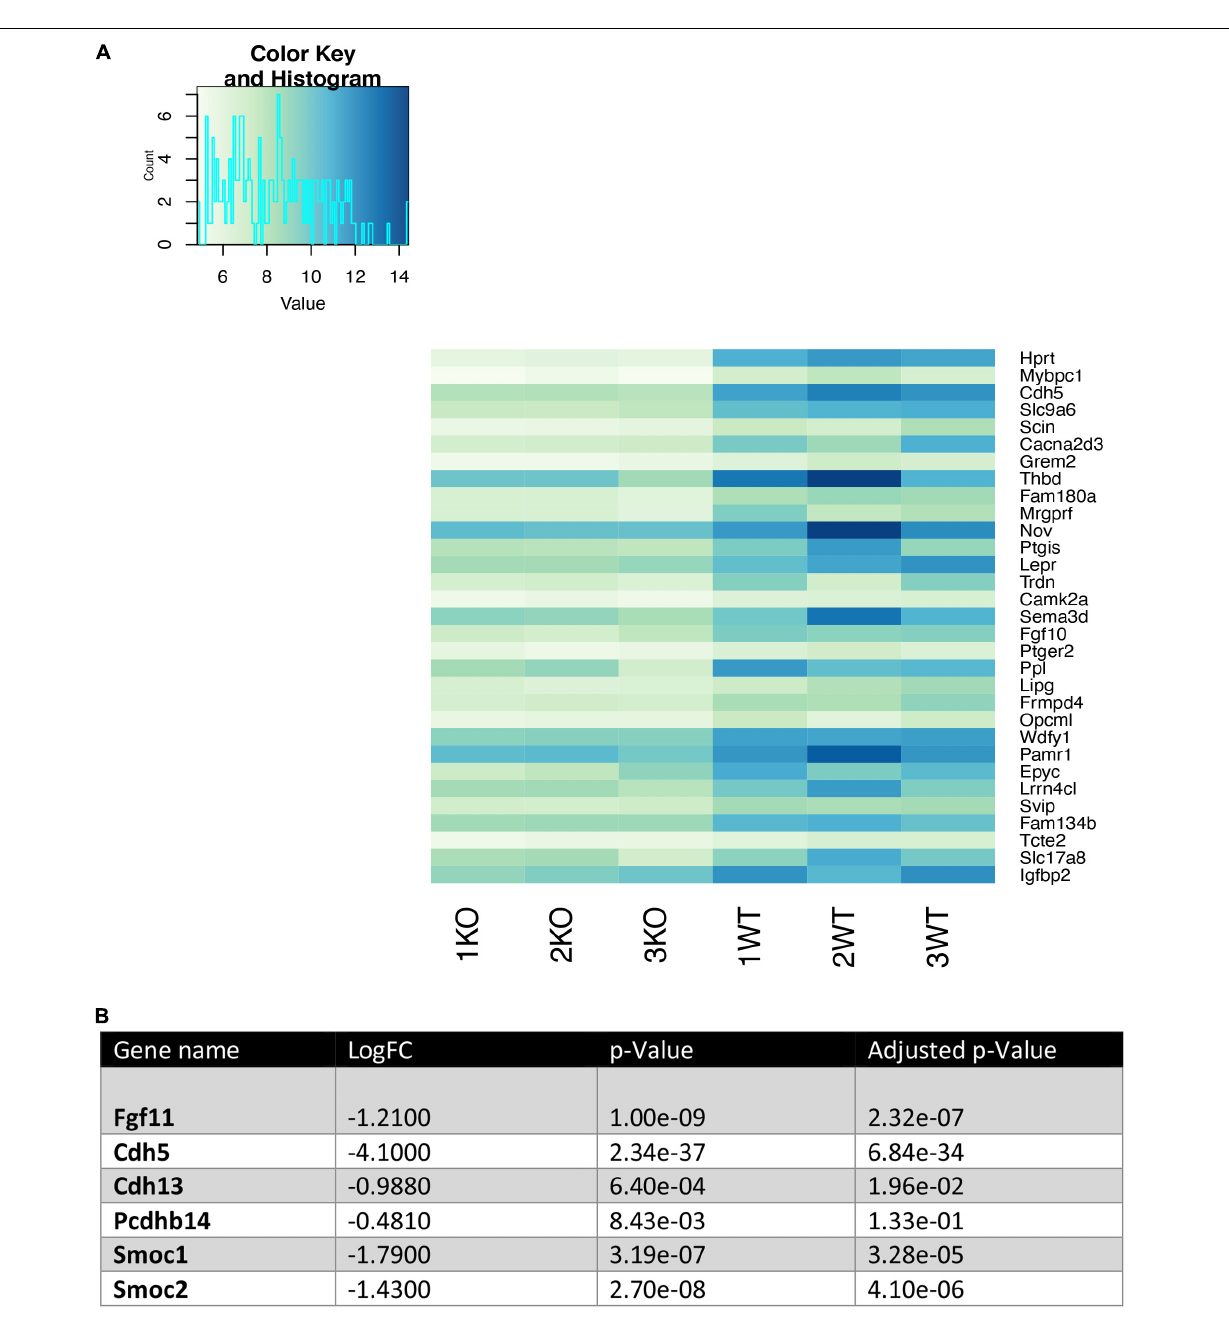
FIGURE 3 | Heatmap of the 30 most downregulated genes in Nhe6 -knockout compared to wildtype endothelial cells. Heatmap shows RNA sequencing results of the 30 most downregulated genes in Nhe6 -knockout (KO) compared to wildtype (WT) cells. (A) Some of the most prominent differences are evident for Hprt , Cdh5 , Thbd , Nov , Ptgis , Lepr , Fgf10 , Ppl , Wdfy1 , Epyc , Slc17a8 , and Igfbp2 genes. These genes affect multiple cellular processes, including: cell cohesion, organization of intercellular junctions, barrier stability, cell adhesion, migration, proliferation, differentiation, and survival. (B) Several other genes that directly or indirectly influence the integrity of the endothelial cell layer were downregulated in KO compared to WT endothelial cells. Samples from six mice were pooled per phenotype and experiment; ( n =